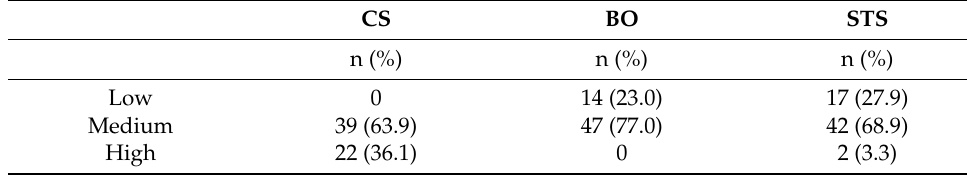
Low = 0–22; Medium = 23–41; High = 42 and higher